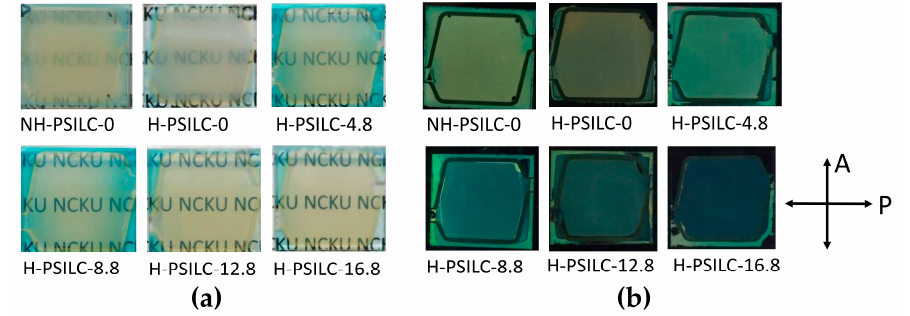
Figure 4. Comparisons of optical observations in different PSILC cells: ( a ) Images of “NCKU” characters. Non-exposed areas show blue color due to the existence of non-reactive photo-initiators; ( b ) The degrees of dark states in cells located between a pair of crossed polarizers.